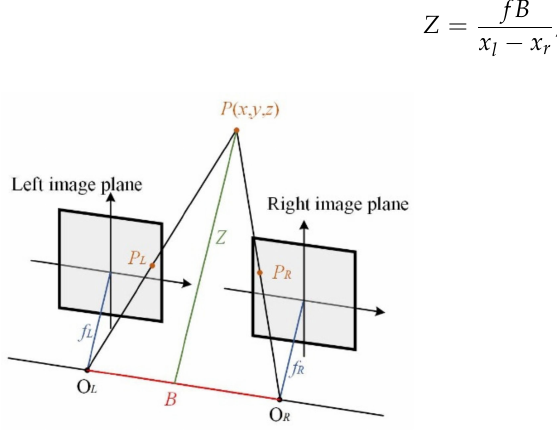
Figure 3. Principle of binocular